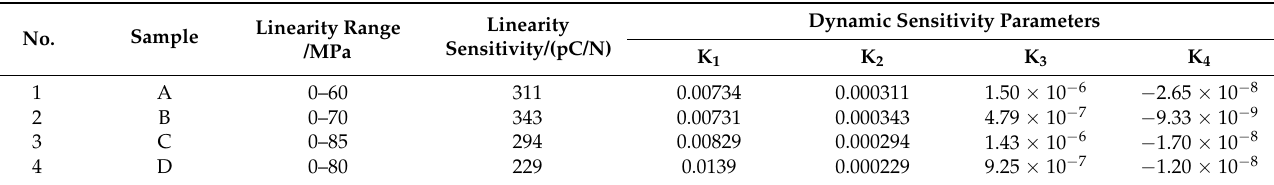
Table 2. The fitting correlation coefficient was >98%. Table 2. Dynamic fitting parameters of the curve.